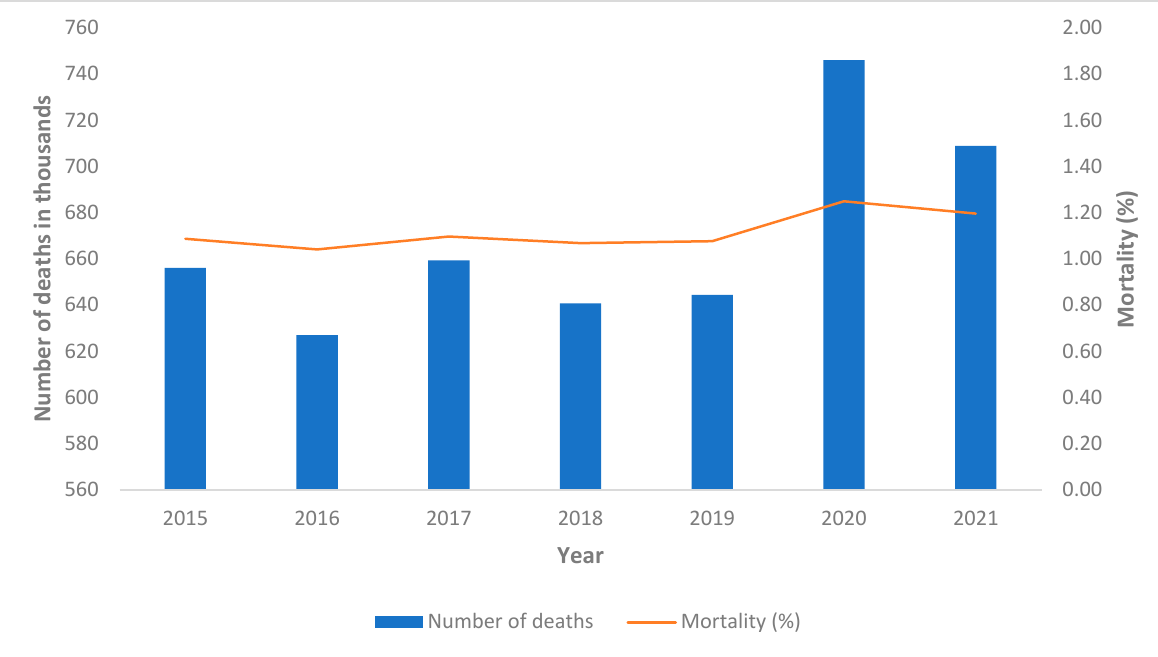
Figure 2. Number of deaths and mortality rate in the Italian population (a).